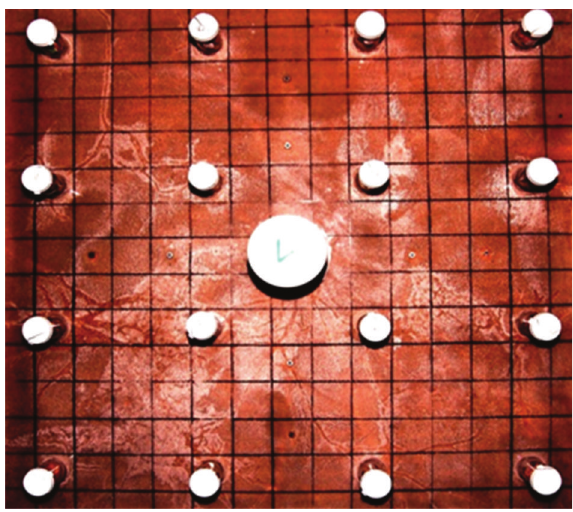
Figure 4: Coptotermes formosanus tunnels in foraging arena.